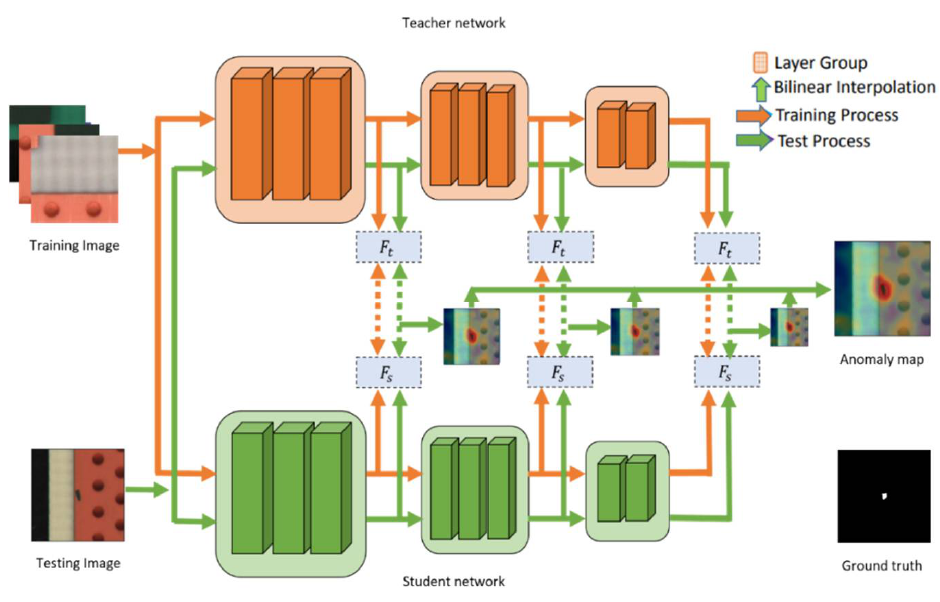
Figure 1. Schematic overview of student–teacher feature pyramid framework.